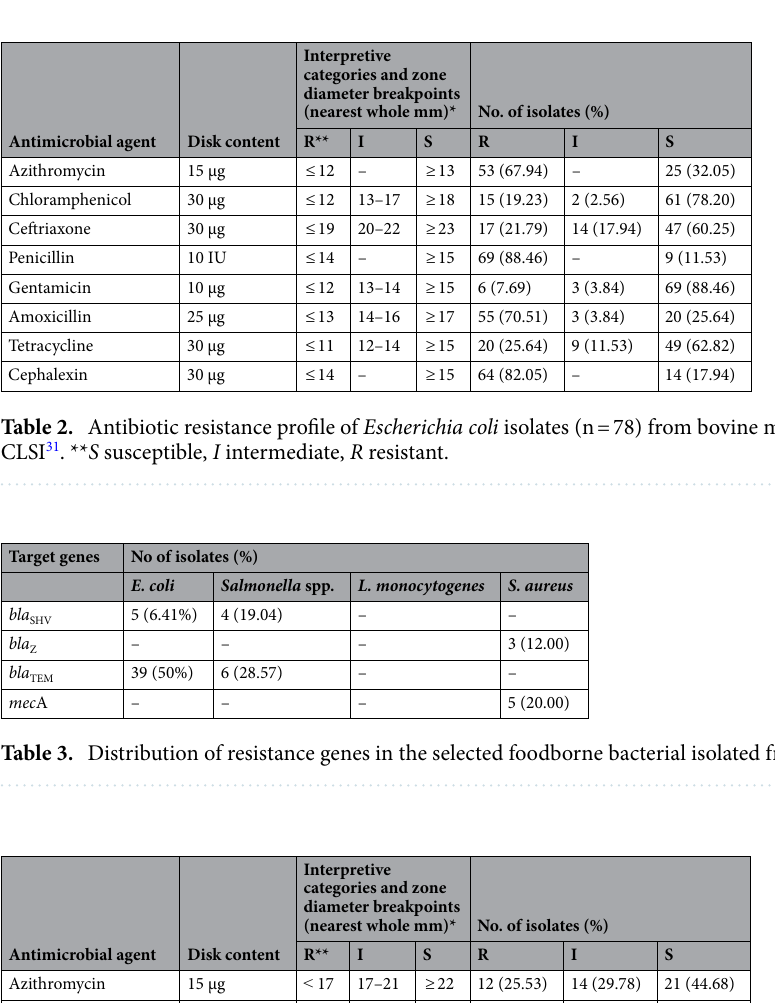
Antimicrobial agent Disk